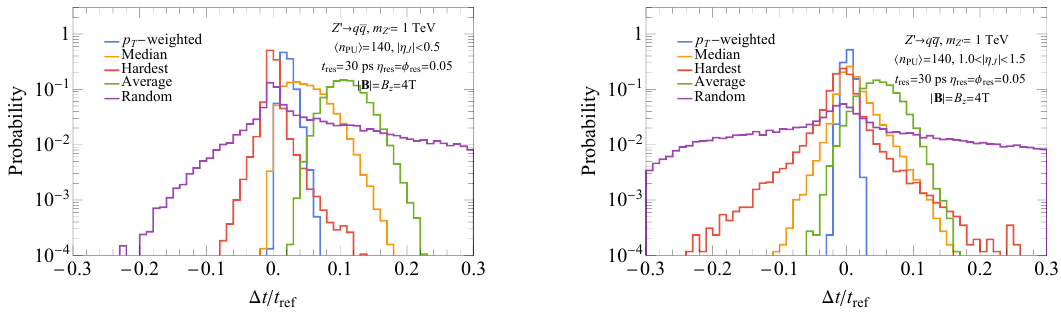
Figure 14 . The relative time difference distribution for | η J | < 0 . 5 (left) and 1 . 0 < | η J | < 1 . 5 (right) with pileup and no subtraction. The | η 0 . 5 plot can be compared with figure 18 (left) J | < and the 1 . 0 < | η 1 . 5 plot can be compared with figure 18 (right). J | <